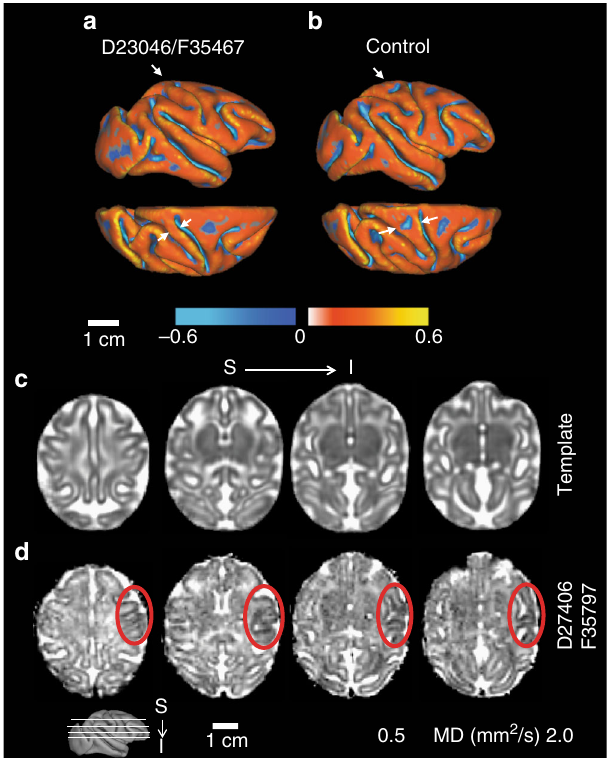
Fig. 7 Cortical surface model and apparent diffusion coef fi cient (ADC) map of fetal brains. For animal F35467, a 3D cortical surface model was generated and curvature of the cortical surface was rendered on the surface ( a , top, lateral view; bottom, dorsal view). Compared to an age-matched control ( b ), a signi fi cantly thinner postcentral gyrus, especially at the dorsal portion, can be detected ( a , arrows). A missing secondary sulcus ( b , asterisks) was also identi fi ed on the postcentral gyrus of animal F35467. c An ADC map generated from 8 control fetuses at gestation age 135dGA ± 2d and d one ADC map from ZIKV animal F35797 are shown at 4 axial slices at indicated levels (inset). Lower ADC is observable on the right hemisphere at the regions of motor, somatosensory, as well as auditory cortices compared to the left hemisphere (red dashed circles)